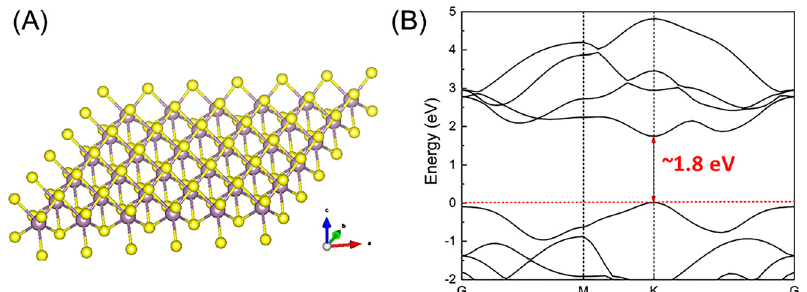
Figure 2: (A) Schematic of the model of MoS 2 for density functional theory (DFT) calculation. Brown and yellow dots represent molybdenum atoms and sulfur atoms, respectively. (B) Band structure of monolayer MoS 2 with valence band maximum and the conduction band minimum at the K point of the MoS 2